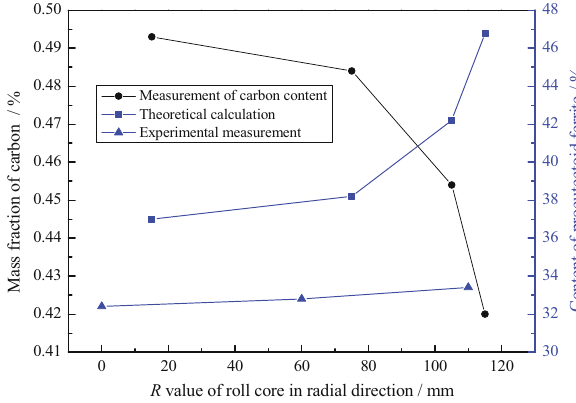
Figure 7: Content of carbon and proeutectoid ferrite at different radial positions of the roll core.